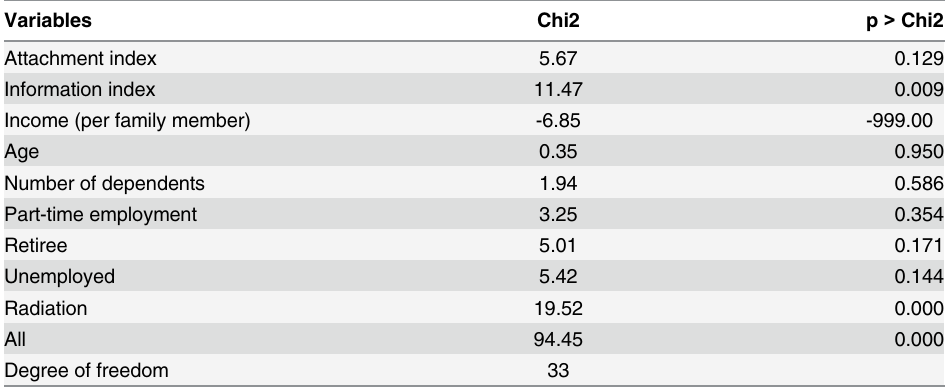
Table 3. Brant test of parallel regression